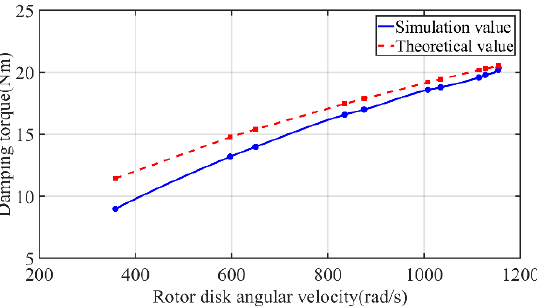
Figure 15. Transient eddy current density distribution of the rotor disks: ( a ) Vector distribution; ( b ) Field distribution.